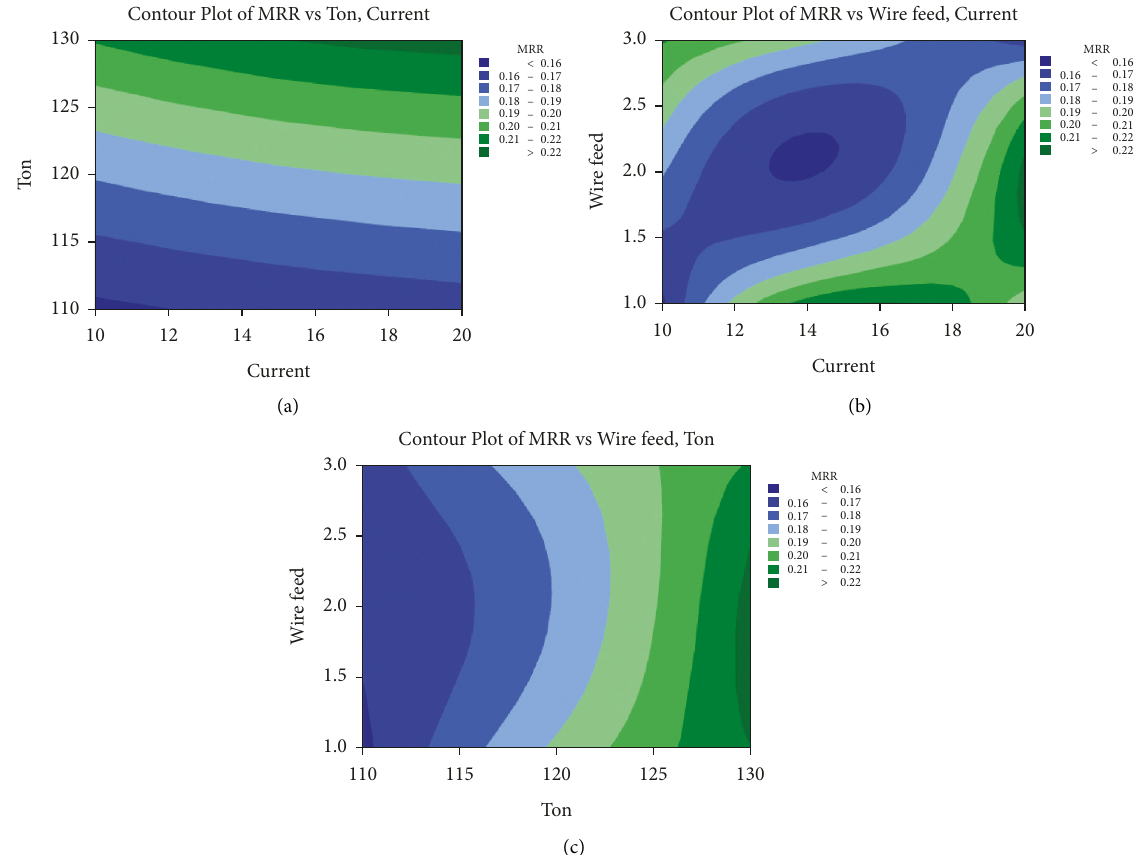
Figure 4: Interaction plots for (a) MRR and (b) R